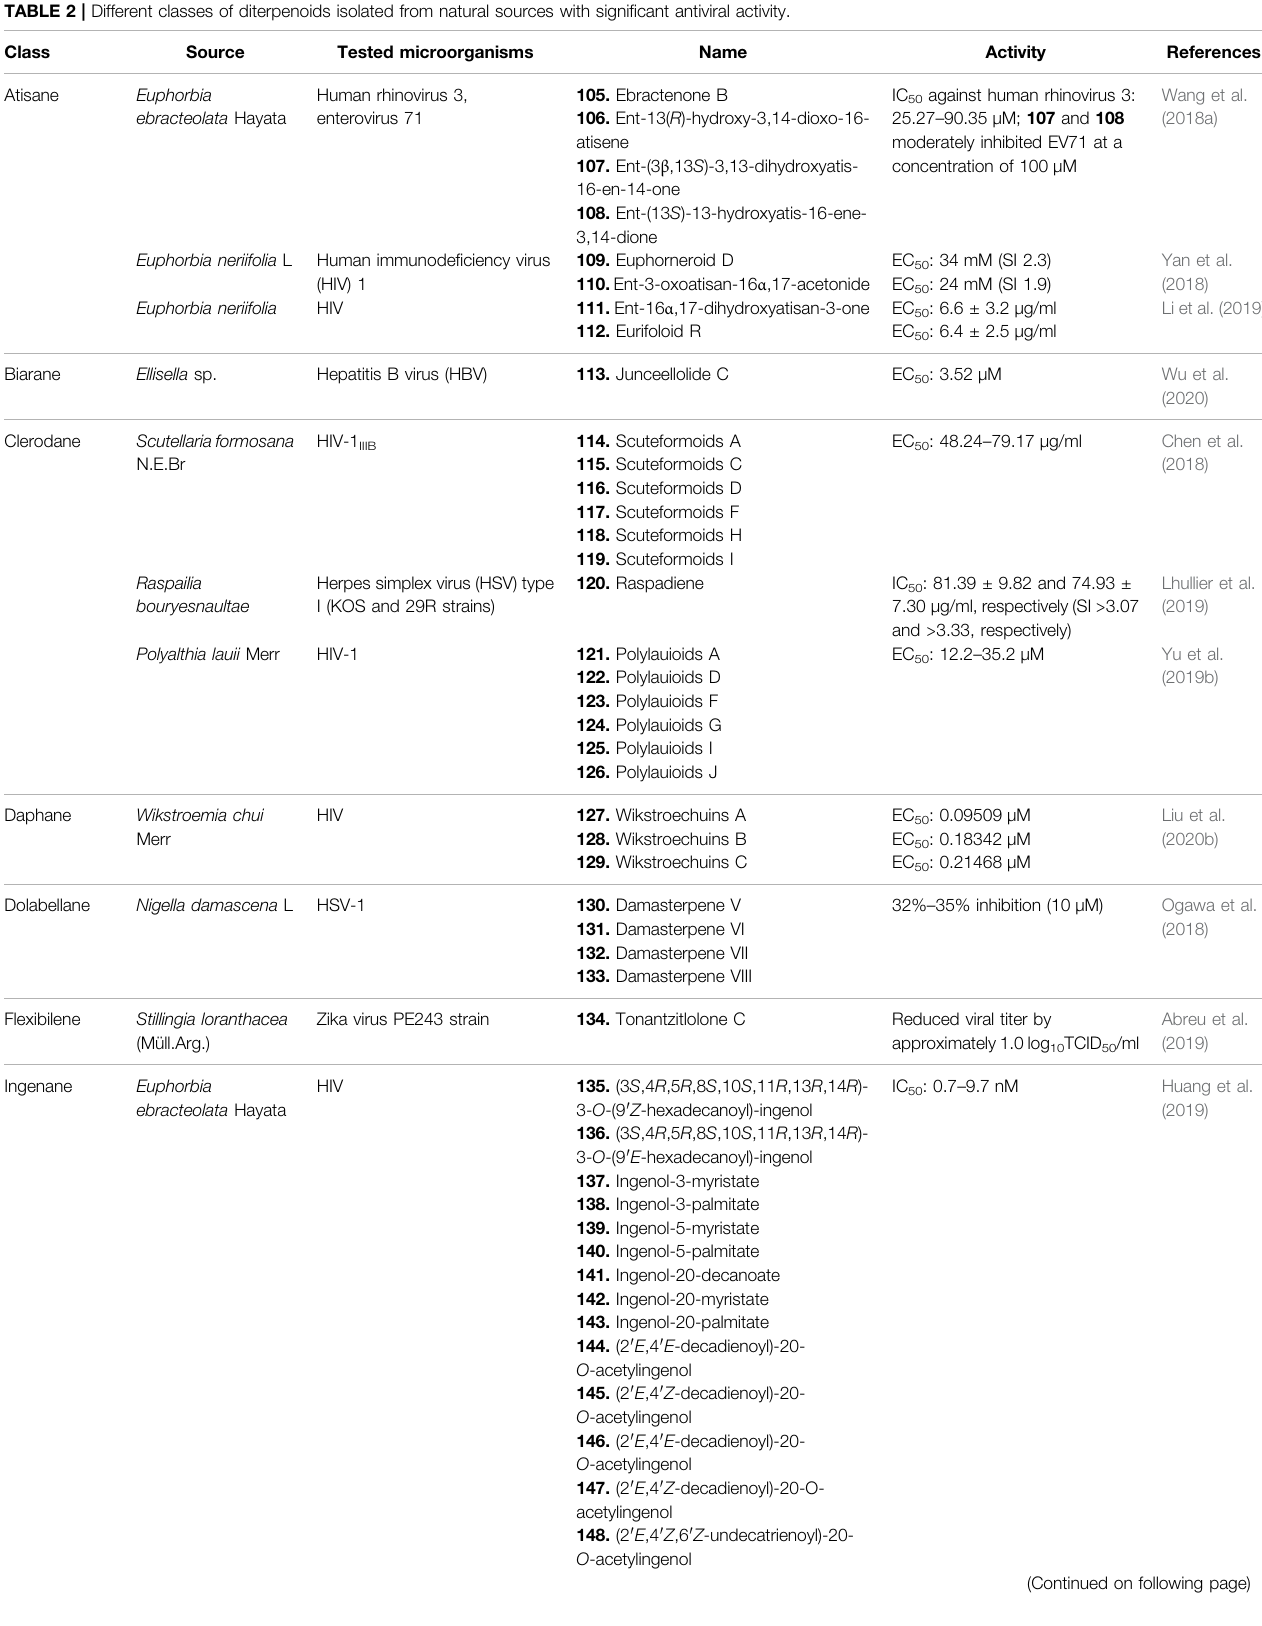
TABLE 2 | Different classes of diterpenoids isolated from natural sources with signi fi cant antiviral activity.